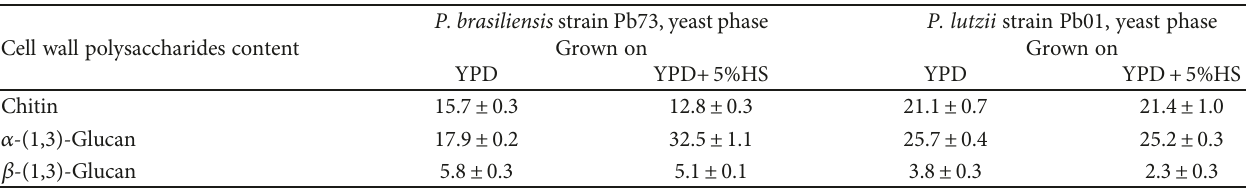
Table 3: Biochemical study of P . brasiliensis and P. lutzii cell wall composition in the presence of horse serum. Yeast cells were grown on YPD or YPD supplemented with 5% horse serum for 4 days at 37 ° C. HS, horse serum. Cell wall polysaccharides